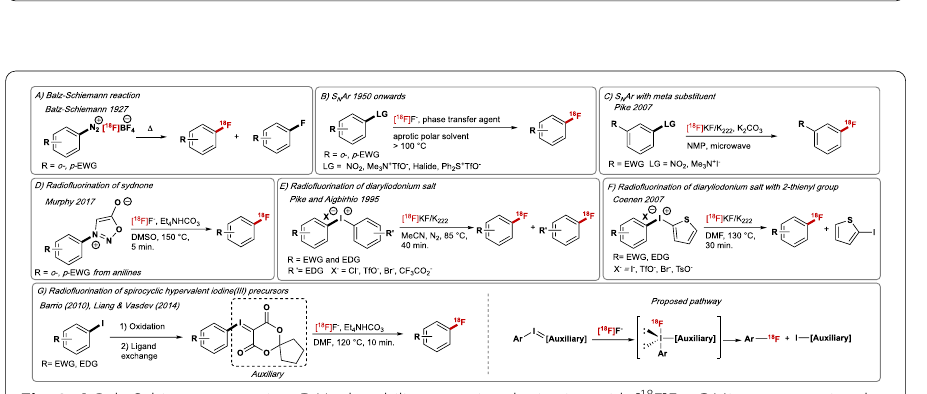
Fig. 2 Timeline for (hetero)aryl– 19 F/ 18 F bond formation from [ 18 F]fluoride. FG EDG. EWG electron-withdrawing group. EDG = group